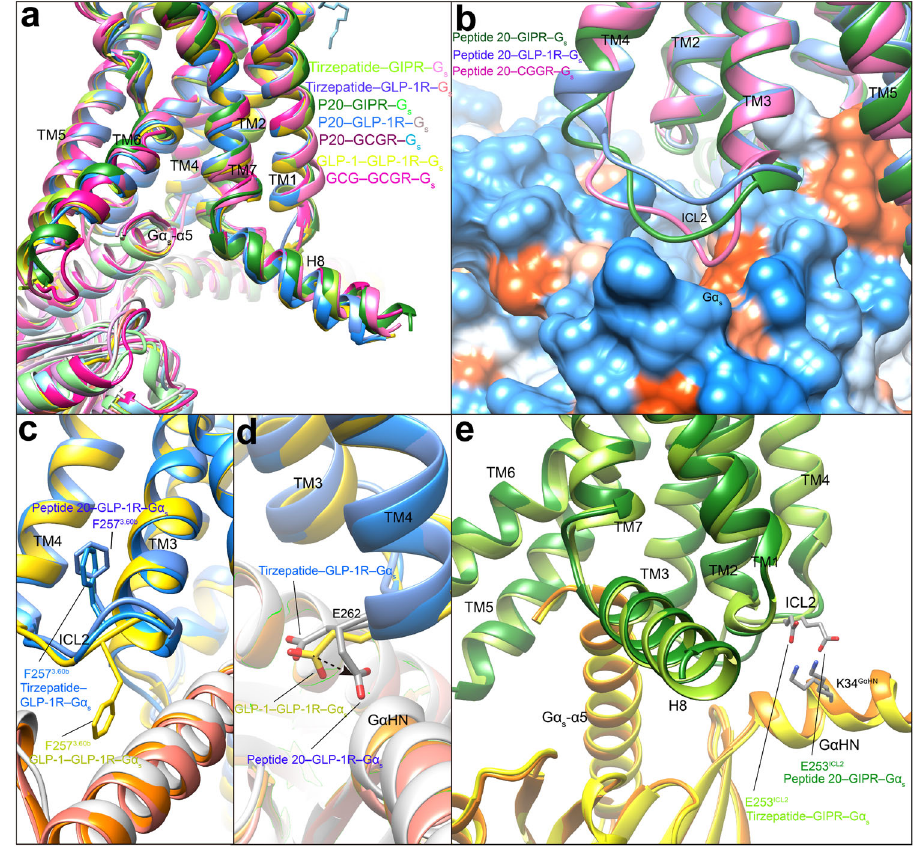
Fig. 6 G protein coupling of multi-targeting agonist-bound GIPR, GLP-1R and GCGR. a Comparison of G protein coupling among GIPR, GLP-1R and GCGR 4, 25, 27 . The G α s α 5-helix of the G α s Ras-like domain inserts into an intracellular crevice of receptor ’ s TMD. The receptors and G proteins are colored as the labels. b Comparison of ICL2 conformation in the peptide 20-bound GIPR, GCGR and GLP-1R. c Comparison of F257 3.60b conformation in the GLP-1R bound by GLP-1, tirzepatide and peptide 20. d Comparison of E262 ICL2 conformation in the GLP-1R bound by GLP-1, tirzepatide and peptide 20. e Comparison of E253 ICL2 conformation in the GIPR bound by tirzepatide and peptide 20. Residues involved in interactions are shown as sticks. Polar interactions are shown as black dashed